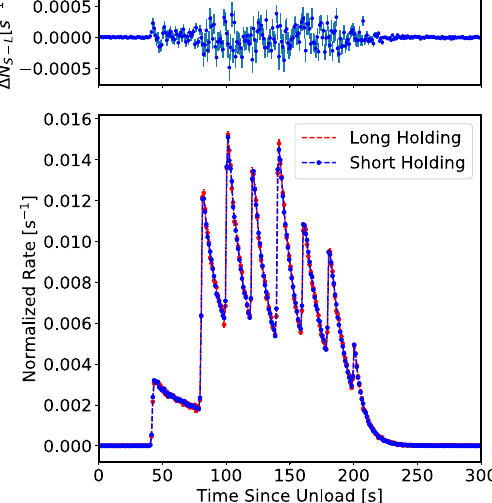
Figure 3. The shape of the average unloading curves for short (blue) and long (red) holding runs are compared to look for phase space evolution. The histograms are normalized to unity by the integral of background subtracted counts over the entire unloading period. The bin-by-bin difference between the normalized count rates in the short and long runs is shown in the top panel.